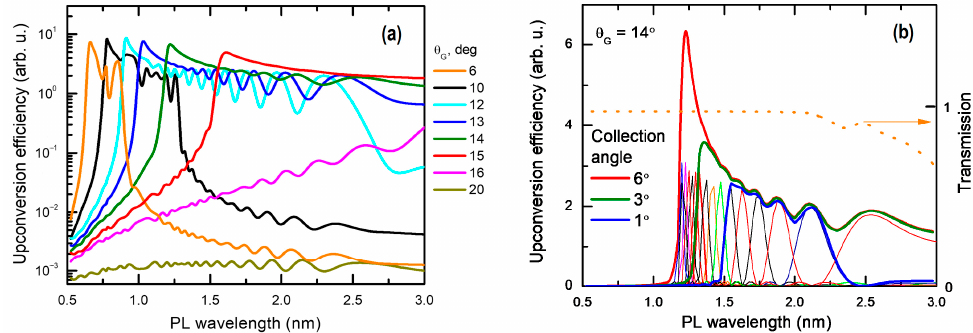
Figure 4. (a) Upconversion spectra width at 6 degree collection angle and variable θ G . ( b ) Upconversion spectra at θ G = 14 ◦ and different PL collection angles (thick lines); thin lines show upconversion spectra for fixed angles (with 0.5 ◦ step). The dotted line represents a 1 mm thick BBO crystal transmission.